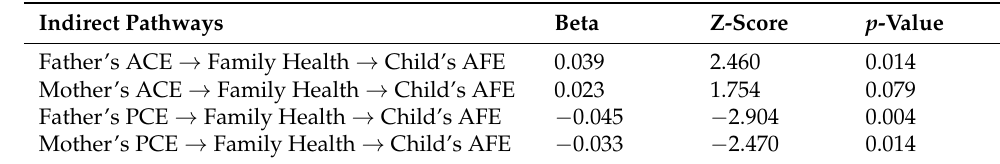
Table 2. Significant family-health-mediated indirect